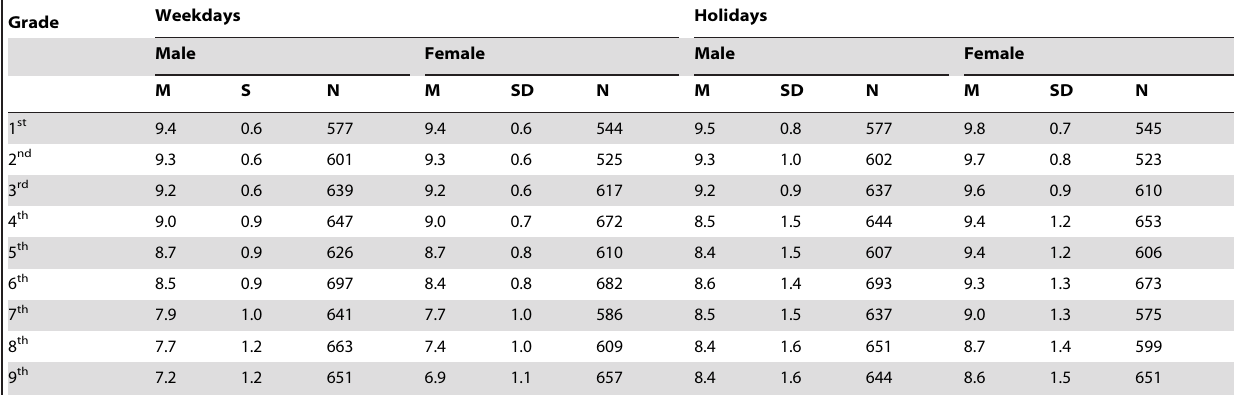
Table 4. Sleep durations on weekdays and holidays.